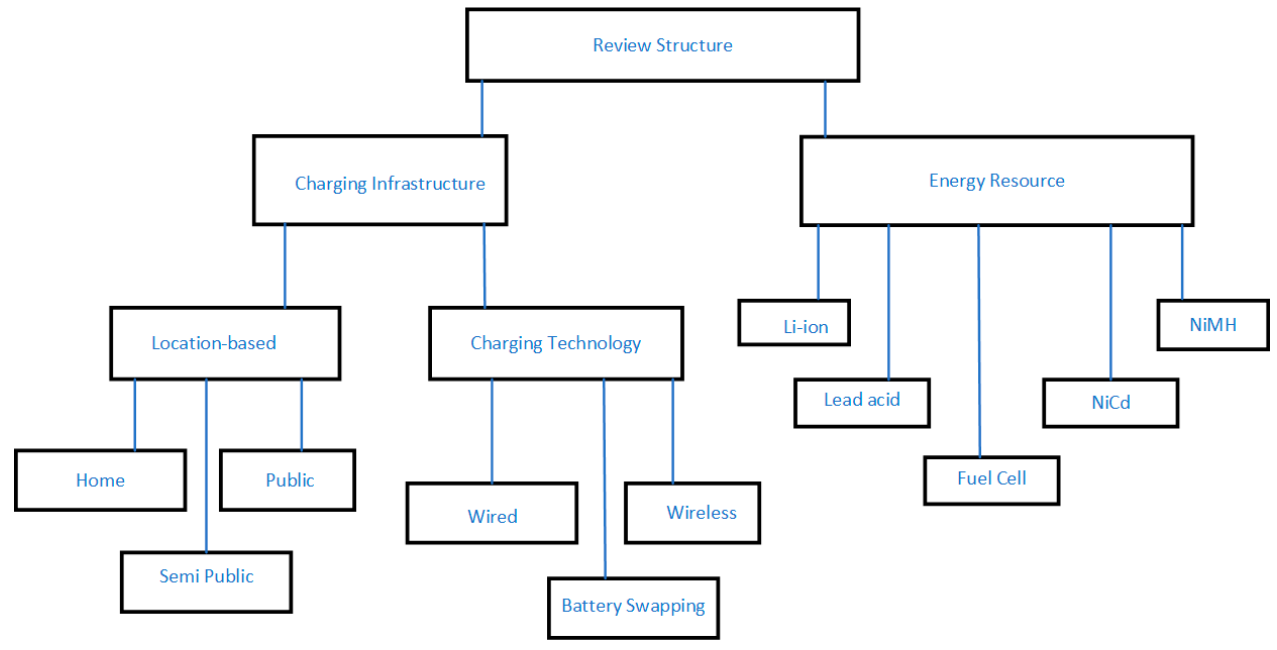
Figure 1. Structure of